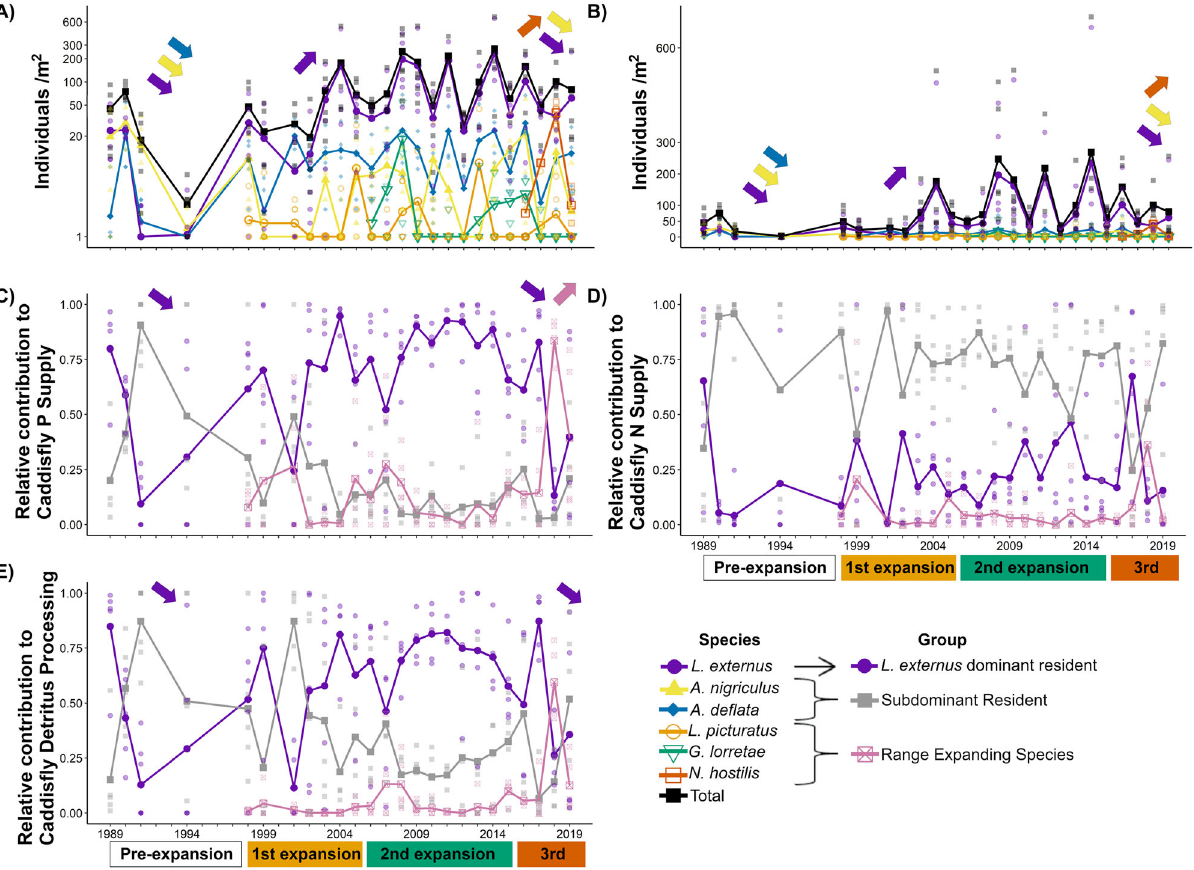
Fig. 2 Larval caddis fl y abundance and predicted relative contributions of caddis fl ies to ecosystem processes in permanent ponds over 30 years at Mexican Cut, Colorado. Natural log-transformed caddis fl y densities ( A , note y -axis is backtransformed to original scale) were averaged across all permanent ponds (range = 3 – 7 ponds per year; individual pond means denoted by semitransparent points). Densities are also presented in original scale ( B ). Colored boxes under x -axes indicate range expansion periods de fi ned by initial dates of upslope range expansion (e.g., orange fi rst expansion box indicates L. picturatus arrived in 1998, green for G. lorretae in 2006, and red for N. hostilis in 2016). Species ’ relative contributions to the caddis fl y assemblage ’ s total were calculated to standardize for interannual variation in the total. We grouped the relative contributions to P supply ( C ), N supply ( D ), and CPOM processing ( E ) of subdominant residents ( Ag. de fl ata and An. nigriculus ) and range expanding species ( L. picturatus , G. lorretae , N. hostilis ) separately for comparison with the dominant resident ( L. externus ). Colored arrows within plot space indicate direction of statistically signi fi cant trends in corresponding species ’ abundance or groups ’ relative contribution during each range